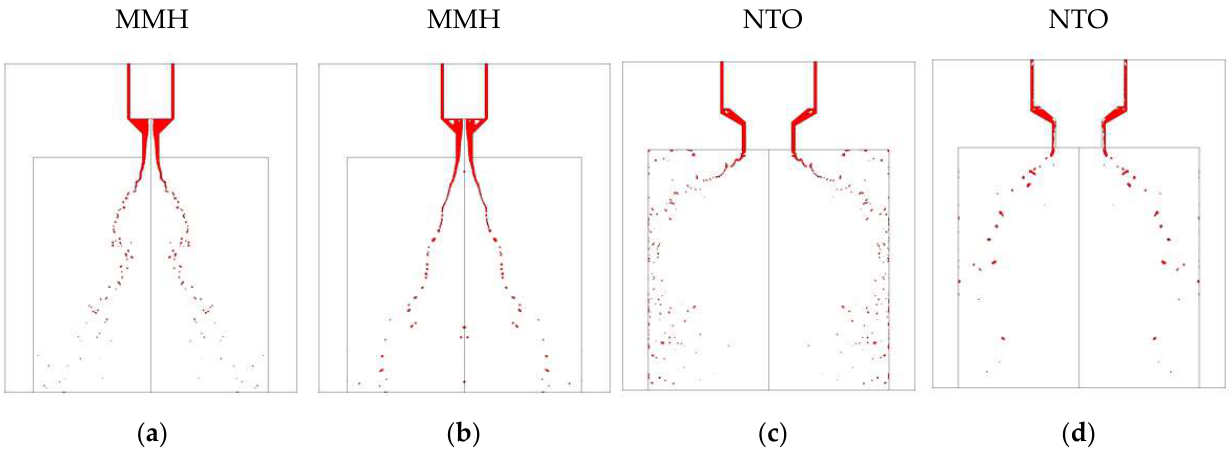
Figure 14. Comparison of MMH spray development at 5 ms under different valve strokes: ( a ) 0.15 mm, ( b ) 0.25 mm, at 0.25 m/s switch speed with downstream orifice plate.